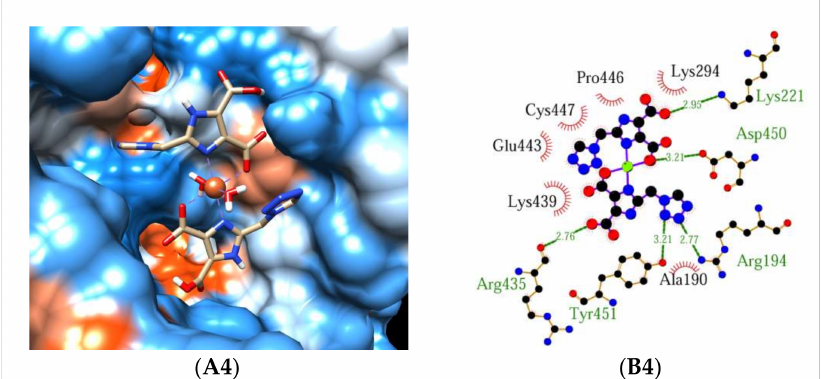
Figure 7. The binding mode of complex 1 -HSA ( A1 , B1 ), complex 2 -HSA ( A2 , B2 ), complex 1 -BSA ( A3 , B3 ), complex 2 -BSA ( A4 , B4 ). Complex 1 or 2 is shown as the cylinder mode and HSA/BSA is represented by the surface model ( A1 – A4 ). Hydrogen bonds between docked complex 1 or 2 and amino acid residues of HSA/BSA ( B1 – B4 ). H-bonds are shown as green lines, the residues that form the hydrogen bond with the complex are labeled in green font, and the residues related to the hydrophobic interaction are labeled in black